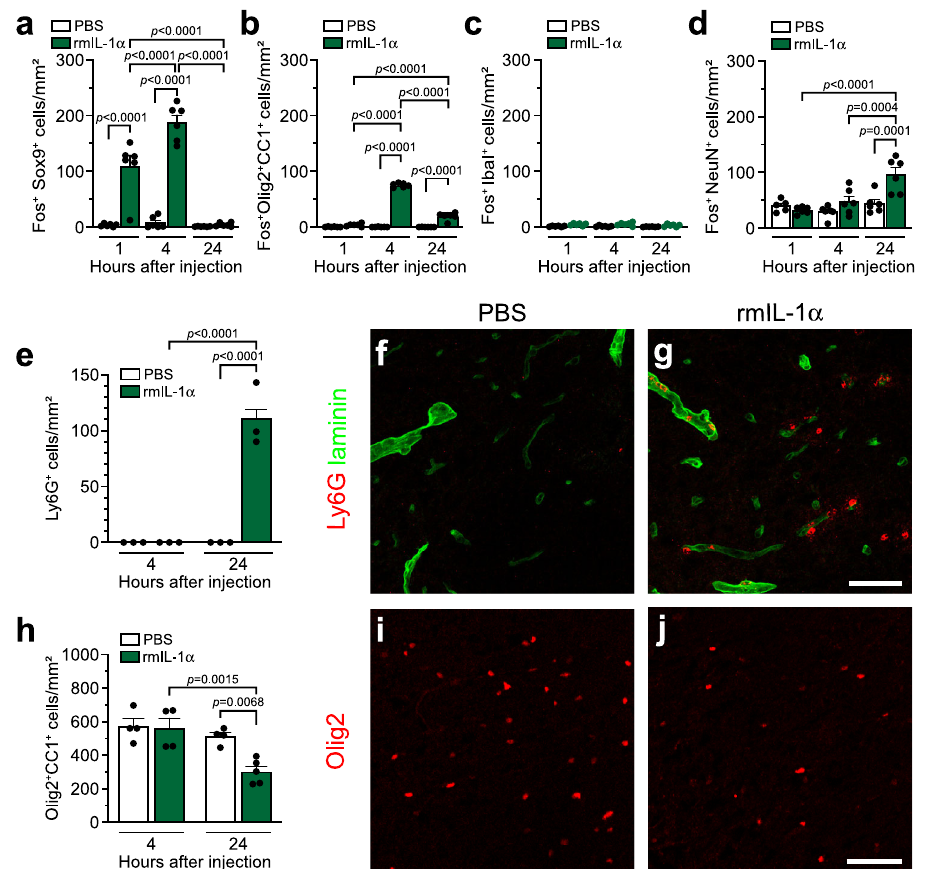
Fig. 2 | Injection of IL-1 α into the CNS of mice induces rapid activation of glial cells,neutrophilin fi ltration,andlossofmatureoligodendrocytesinthespinal cord. a – d Quanti fi cation of the activation marker Fos in astrocytes (Fos + Sox9 + cells), oligodendrocytes (Fos + Olig2 + CC1 + ), microglia (Fos + Iba1 + ), and neurons (Fos + NeuN + )inthespinalcordofC57BL/6miceinjectedwitheitherPBSorrmIL-1 α i.c.m. and killed at 1, 4 or 24h post-injection ( n =6 mice/group). e Quanti fi cation of the totalnumberofLy6G + neutrophilsthatin fi ltratedthespinalcordat4and24hpost- injection ofPBSor rmIL-1 α ( n =3mice/group). f , g Representative confocalimages showing Ly6G (amarkerof neutrophils,red)and laminin (amarker of bloodvessel basementmembranes,green)immunostainingsinthespinalcordofC57BL/6mice injectedwith eitherPBS( f )orrmIL-1 α ( g )at24hpost-injection. h Quanti fi cationof